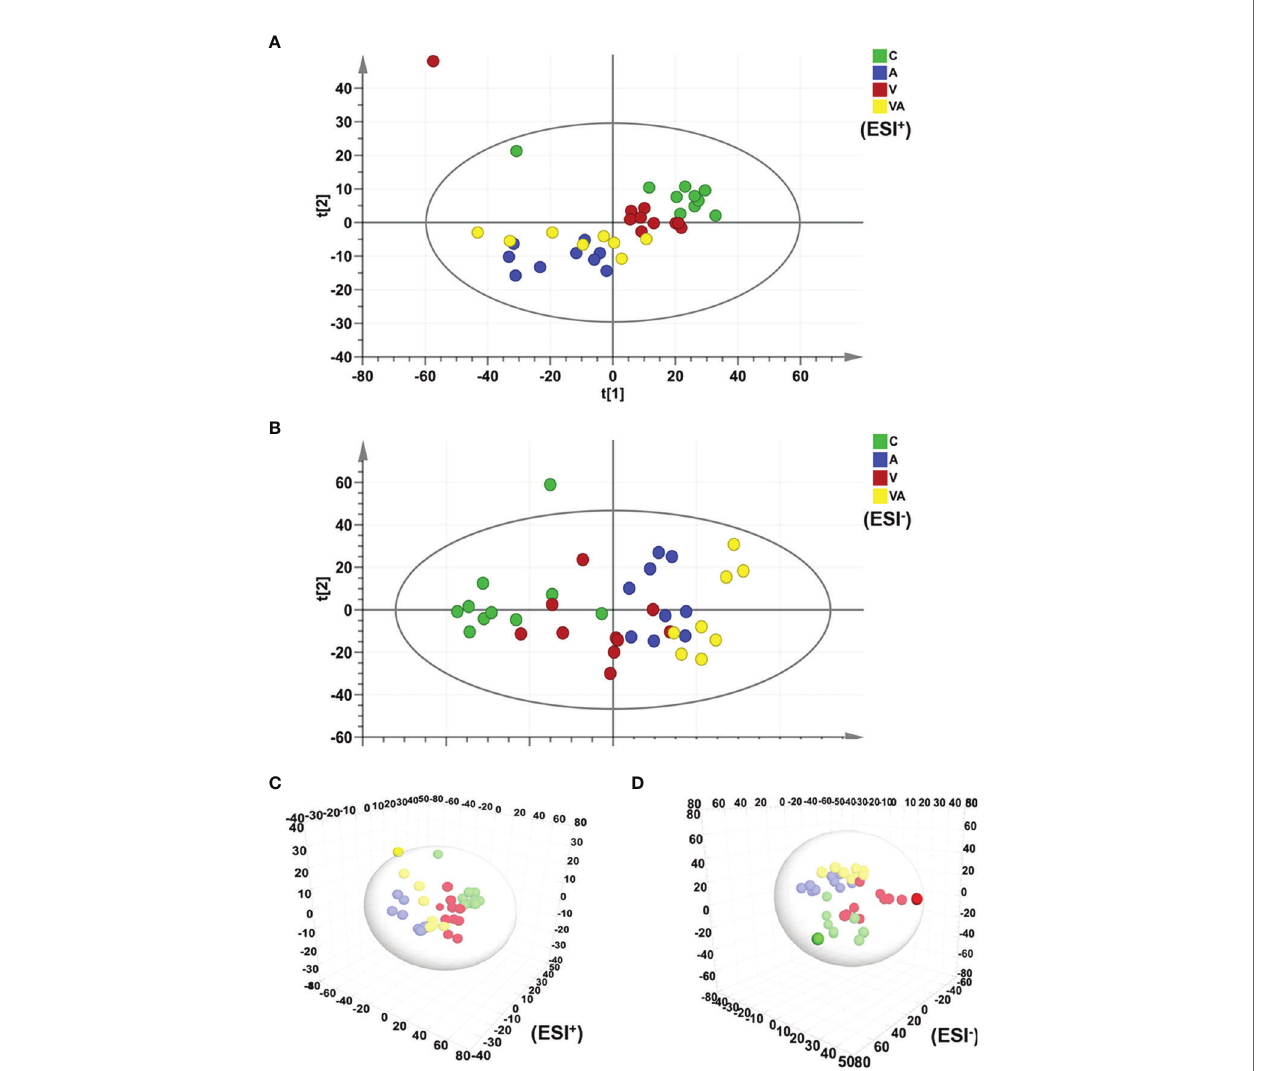
FIGURE 3 | PCA score plot based on the data of ESI +/ − modes. (A) PCA score plot of all groups in ESI + mode. (B) PCA score plot of all groups in ESI − mode. (C) 3D scatter plot of all groups in ESI + mode. (D) 3D scatter plot of all groups in ESI -